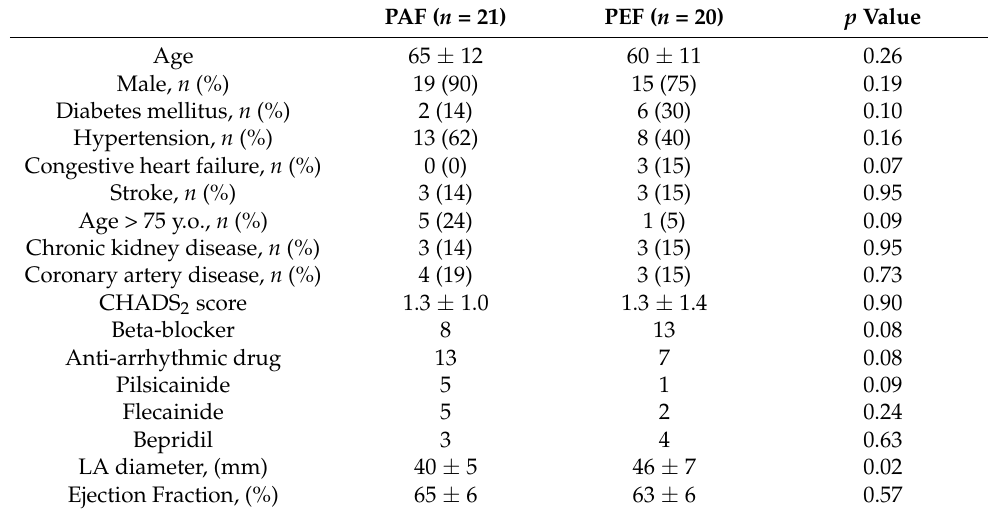
Table 1. Baseline characteristics ( n = 41).